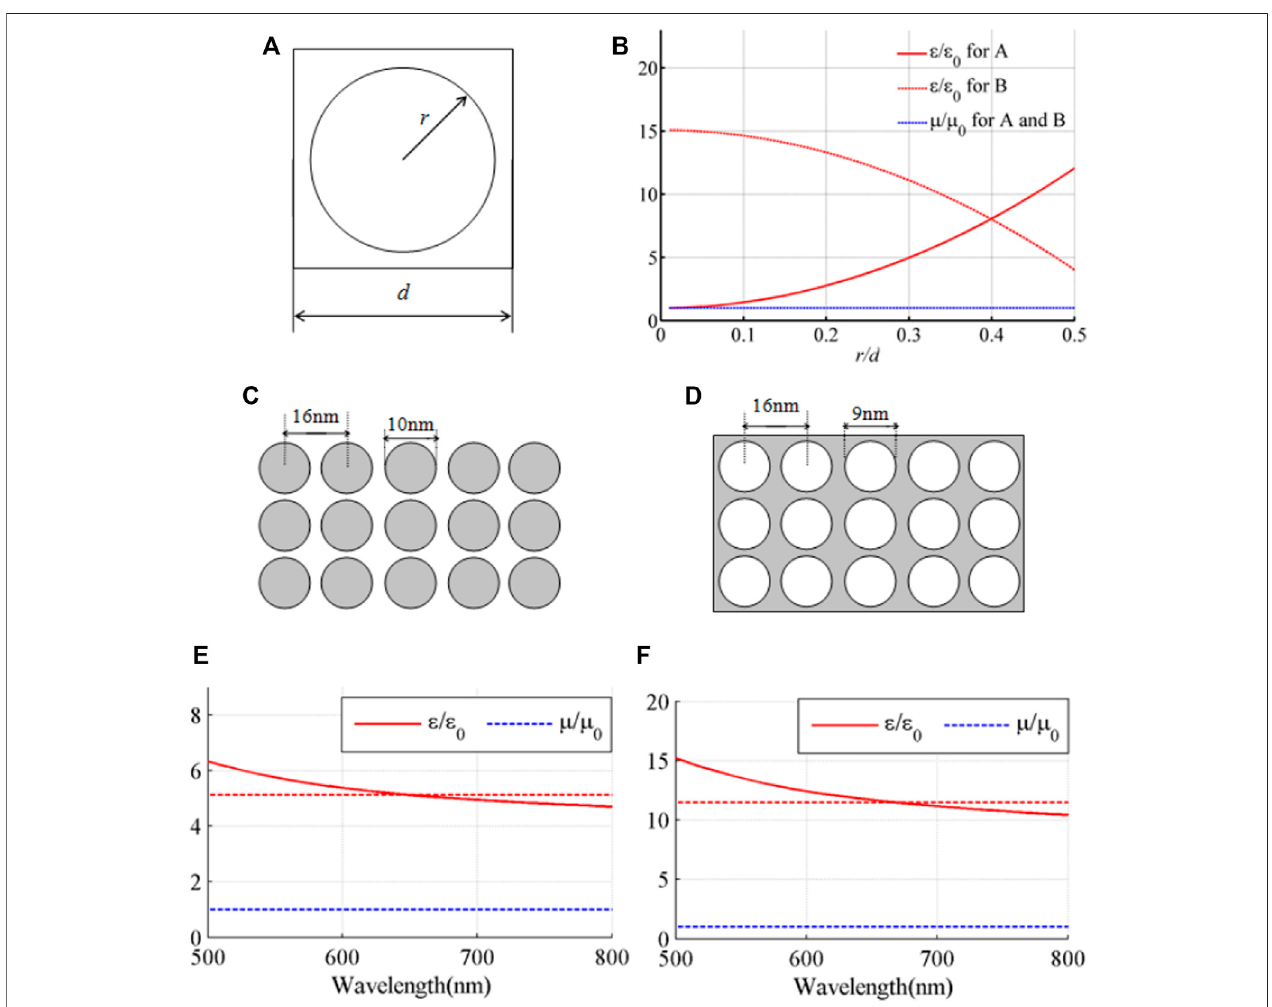
FIGURE 3 | (Color online) (A) Illustration of unit cells for both layers. (B) The effective permittivity for layers A (red solid) and B (red dashed) and the relative permeability (blue dashed) (C – D) Illustration ofthe silicon (gray) microstructures for layers A (C) and B (D) (E – F) The effective parameters for layers A (E) and B (F) when changing the incident wavelength. Red (blue) data: relative permittivity (effective relativepermeability). The dashed red lines give the ideal values of relativepermittivity for the two layers according to the scattering cancellation method.